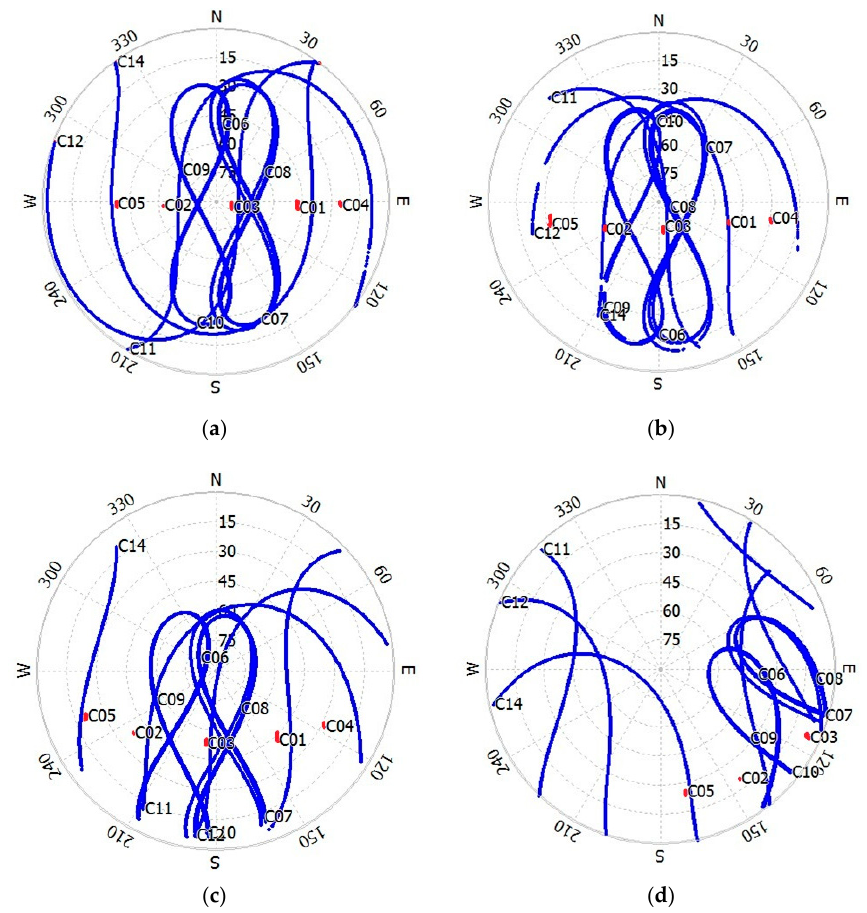
Figure 2. Sky plots of BDS satellites on Day 029/2015. SIN1 ( a ), DLTV ( b ), JFNG ( c ), and KZN2 ( d ). Red represents GEO satellites, and blue represents IGSO and MEO satellites.